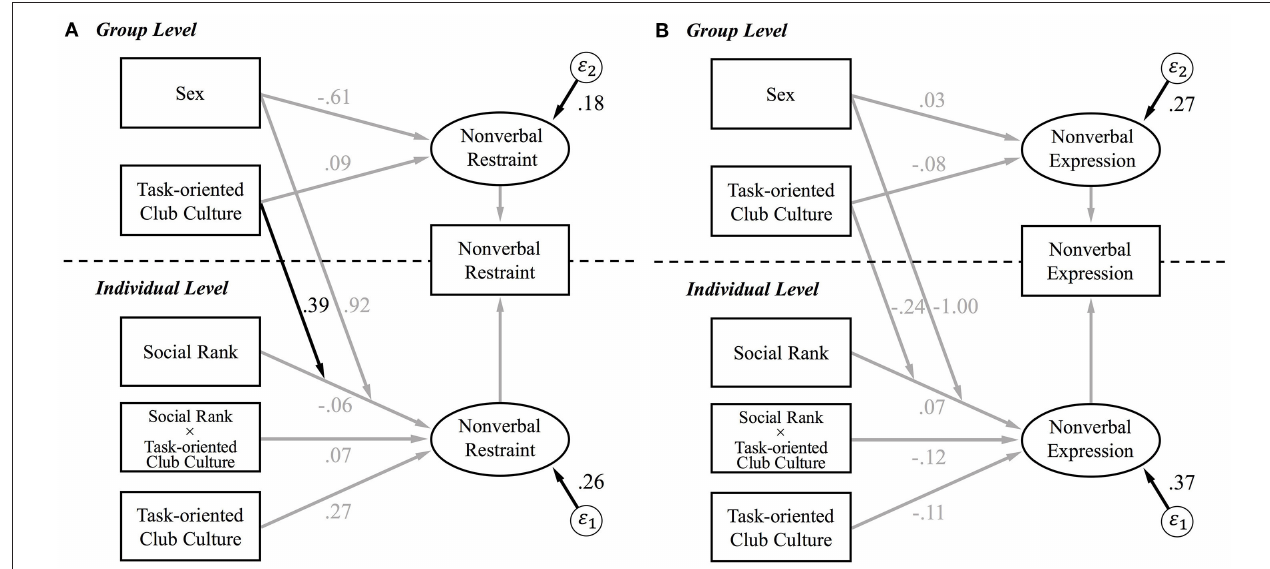
FIGURE 1 | Hierarchical linear modeling results predicting nonverbal behavior as a function of social rank and task-oriented club culture. Black lines represent significant paths, and gray lines represent nonsignificant paths. Social Rank was a dichotomous variable with − 0.5 = club member and + 0.5 = club leader. Sex was also a dichotomous variable where 0 = male and 1 = female. Task-oriented club culture at both levels and sex were centered. (A) The cross-level interaction of individual-level social rank and group-level task-oriented club culture on nonverbal suppression was significant. Estimated residual variance of the random slope was 0.76. (B) The cross-level interaction of individual-level social rank and group-level task-oriented club culture on nonverbal expression was not significant. Estimated residual variance of the random slope was 1.00. significant ( b = − 0.09, SE = 0.13, p = 0.47). That is,